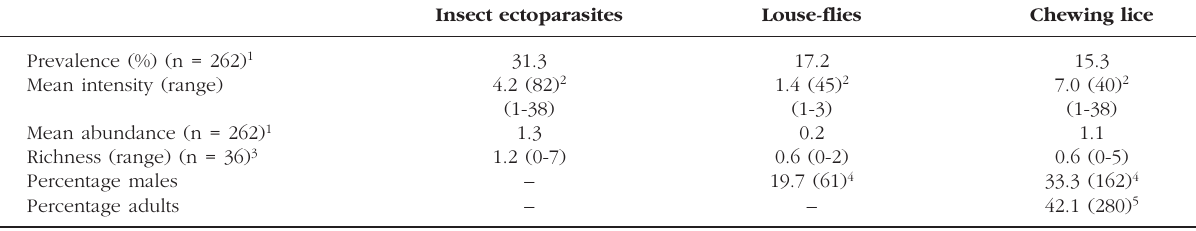
Table II. – Parasitological parameters of insect ectoparasites collected from wild passerine birds in the Czech